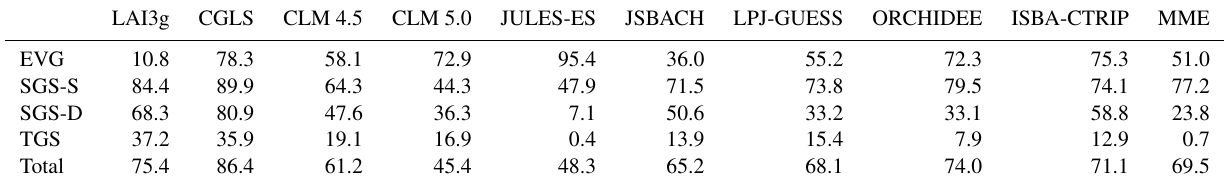
Table 2. The fraction of land grid cell in agreement with MODIS for each satellite product and each land surface model in the four growing season types. Values are reported in percentages and refer to the coloured regions in Fig. 2d and g and Fig. 3.